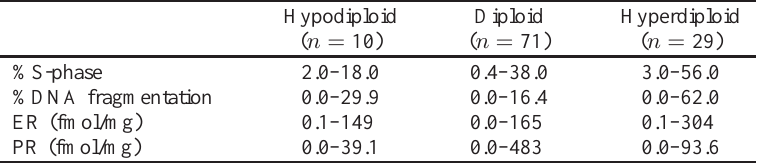
Table 1 Range values for %S-phase, %DNA fragmentation, ER/PR receptors measured in DNA hypodiploid, diploid and hyperdiploid breast cancer tumours